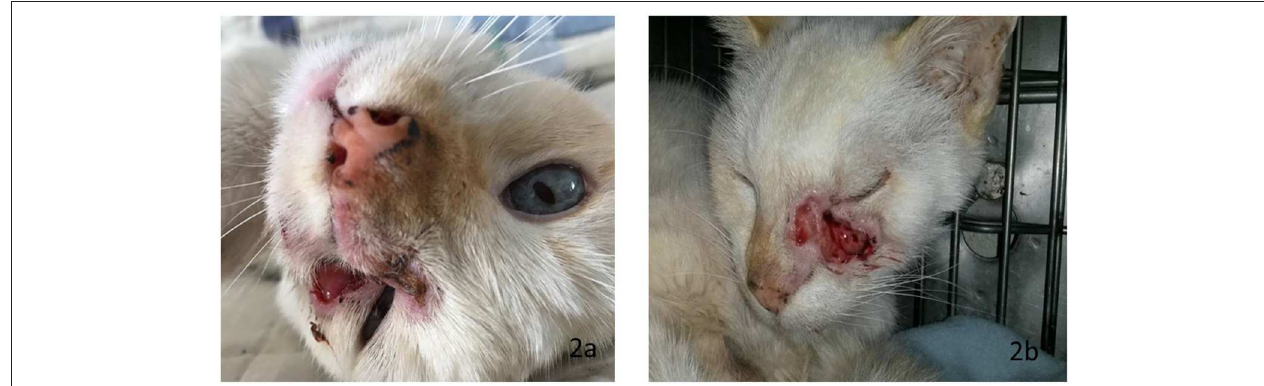
FIGURE 2 | (a) Eyes: light blue, large nut-shaped, separated, slightly oblique. (b) Fistula in the left maxilla with secretion and foul odor.